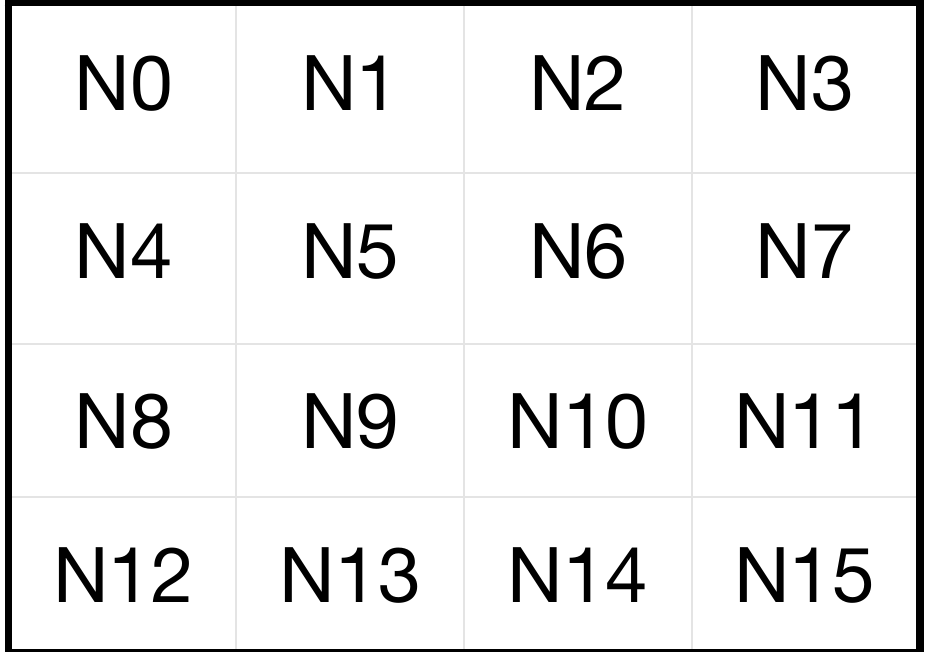
Figure 1. Representation of the full interaction arena split across 16